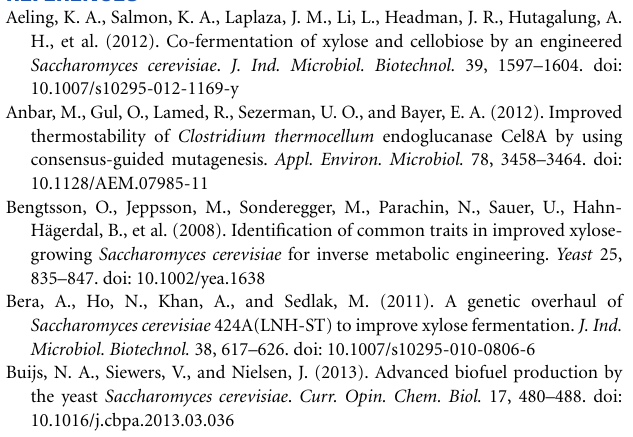
cellulose fermentation, or in a combined process where both xylose and cellulose are utilized by a single strain in a sequential manner (B) or within one reaction (C)